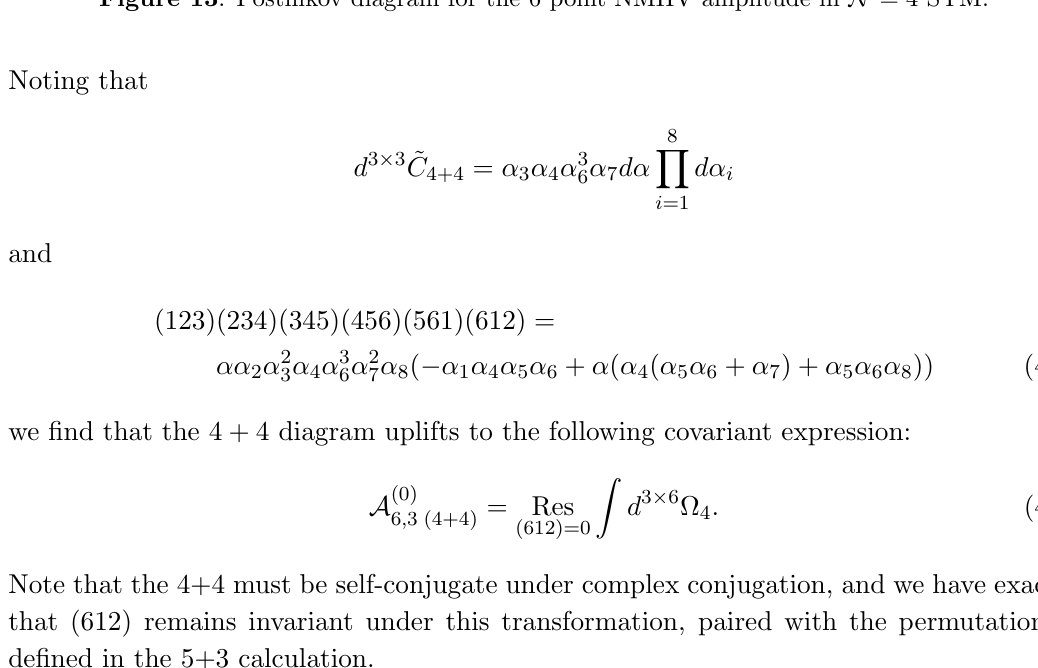
Figure 13 . Postnikov diagram for the 6 point NMHV amplitude in N = 4